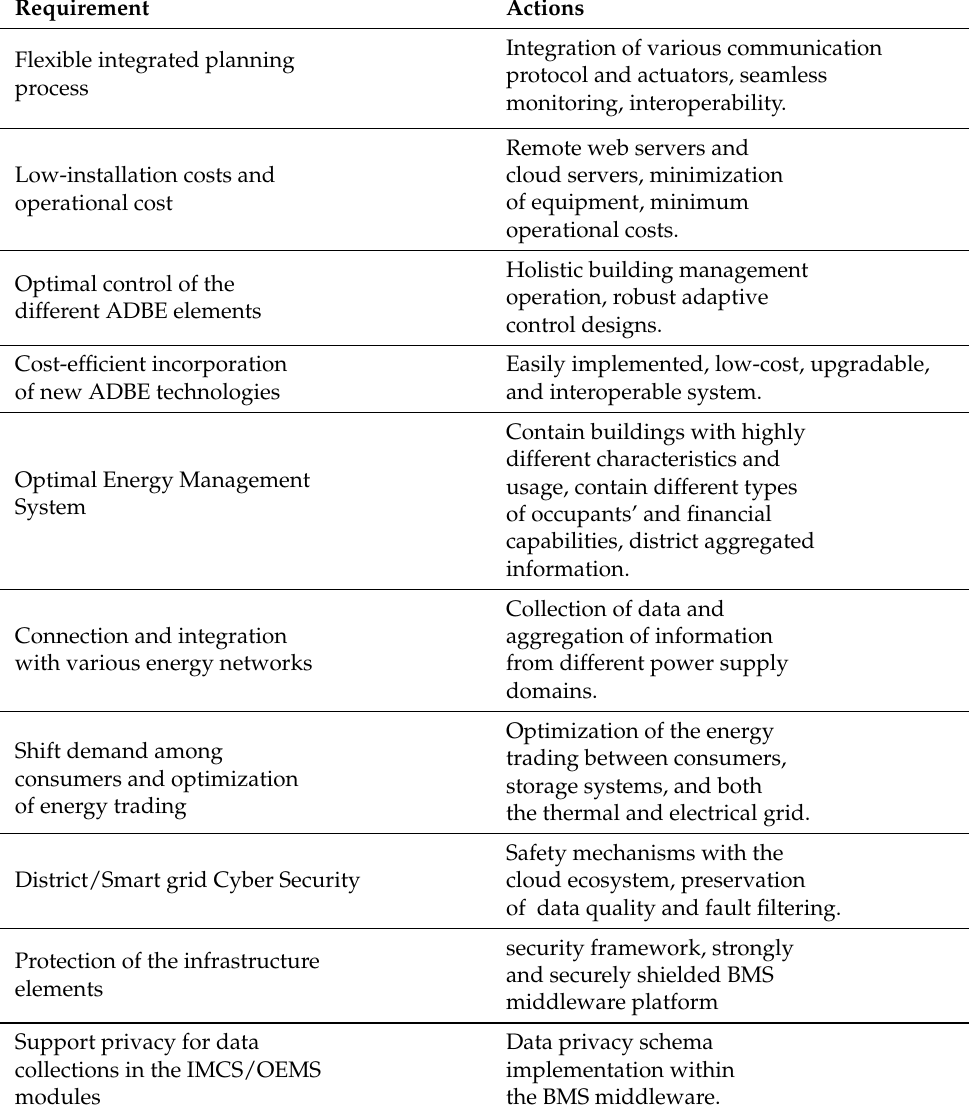
Table 1. User and system